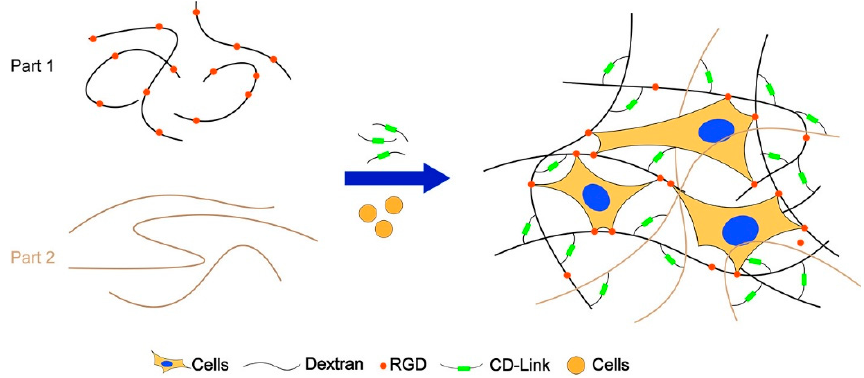
Figure 2. Illustration of fabricating 3D dextran hydrogels with different clustered RGD compositions. Table 1. Four different RGD distributions were performed for 3D dextran hydrogel. The levels of RGD clustering decreased from Group 1 to Group 4.